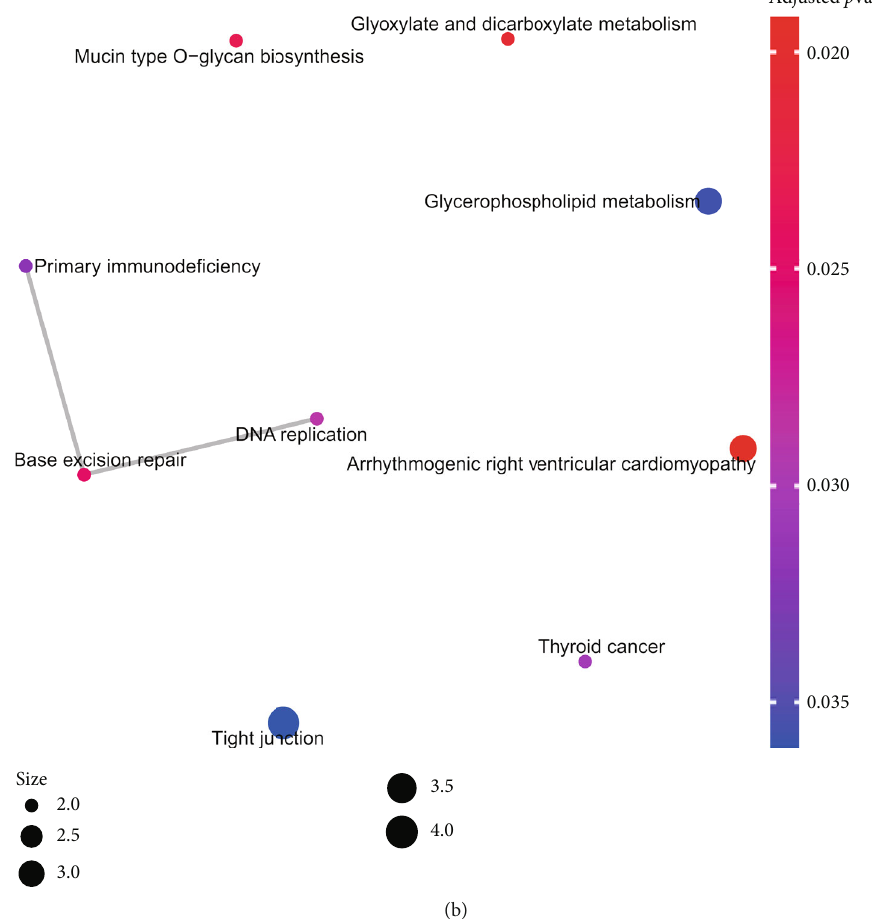
Figure 7: KEGG enrichment plots of the intersection genes from CCDC80 positively related coexpressed genes (CEGs) and downregulated di ff erentially expressed genes (DEGs) (a), and CCDC80 negatively related CEGs and upregulated DEGs